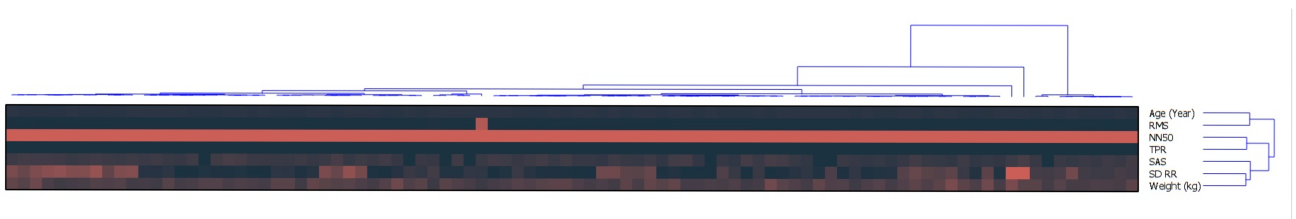
Figure 5. Sixty seconds ECG signal representation of the anxiety-suffering student including ( a ) raw signal, ( b ) filtered signal, and ( c ) R-R interval.